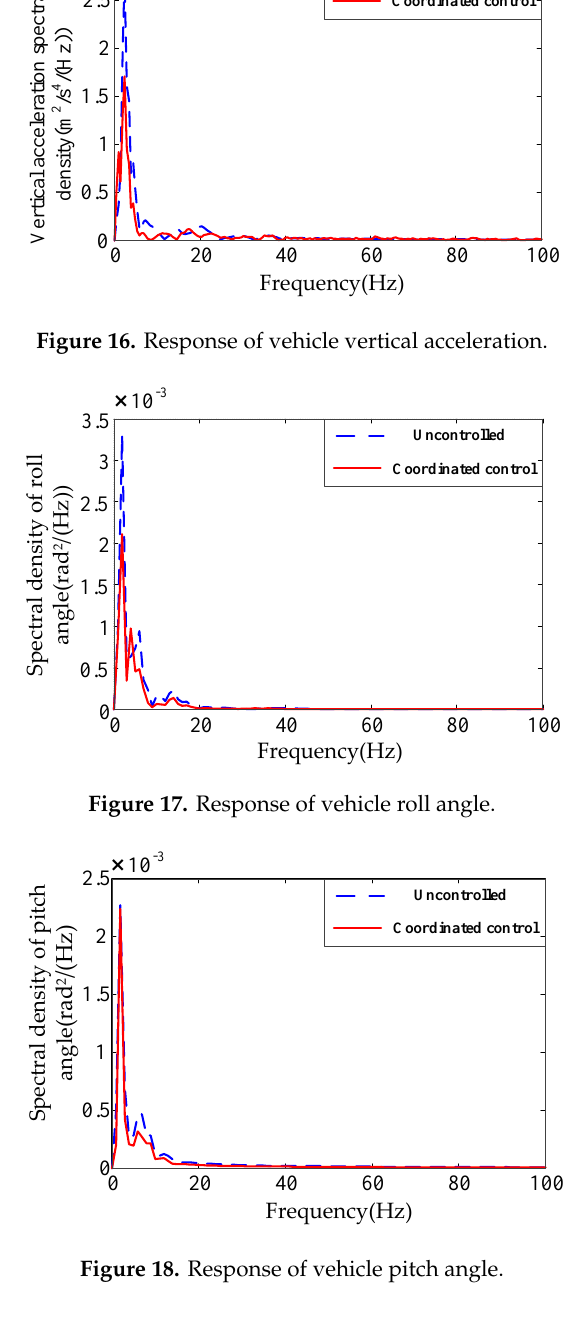
Figure 19. Response of dynamic stroke for front left suspension. 6. Verification of Bench Test In view of the safety uncertainty and the limitation of the research conditions of the real vehicle test, the test was realized by setting up a test bench. There is no indirect transformation between the straight condition and the steering condition in a bench test, so the complex conditions were divided into a straight condition and a steady-state steering condition under standard-B road excitation. If the results of the tests under these two conditions are improved, the correctness of the simulation test can be indirectly proved. In this experiment, MTS320-035 four-post test rig was used to simulate the road input in the course of vehicle driving. Figure 20 is the structure of the test bench. Figure 20. Structure of the test bench.